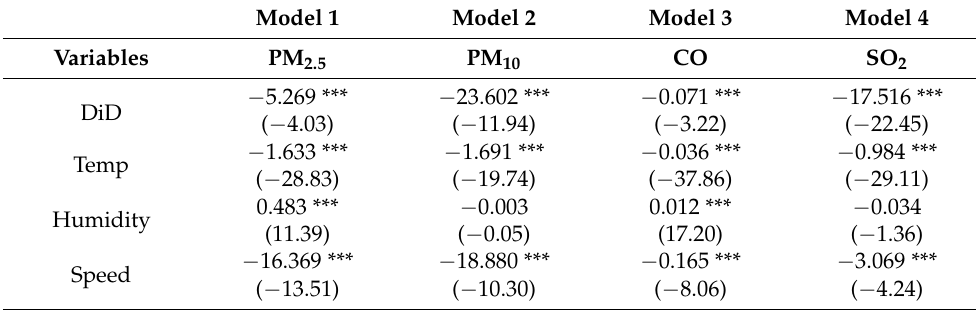
Table 7. DID model